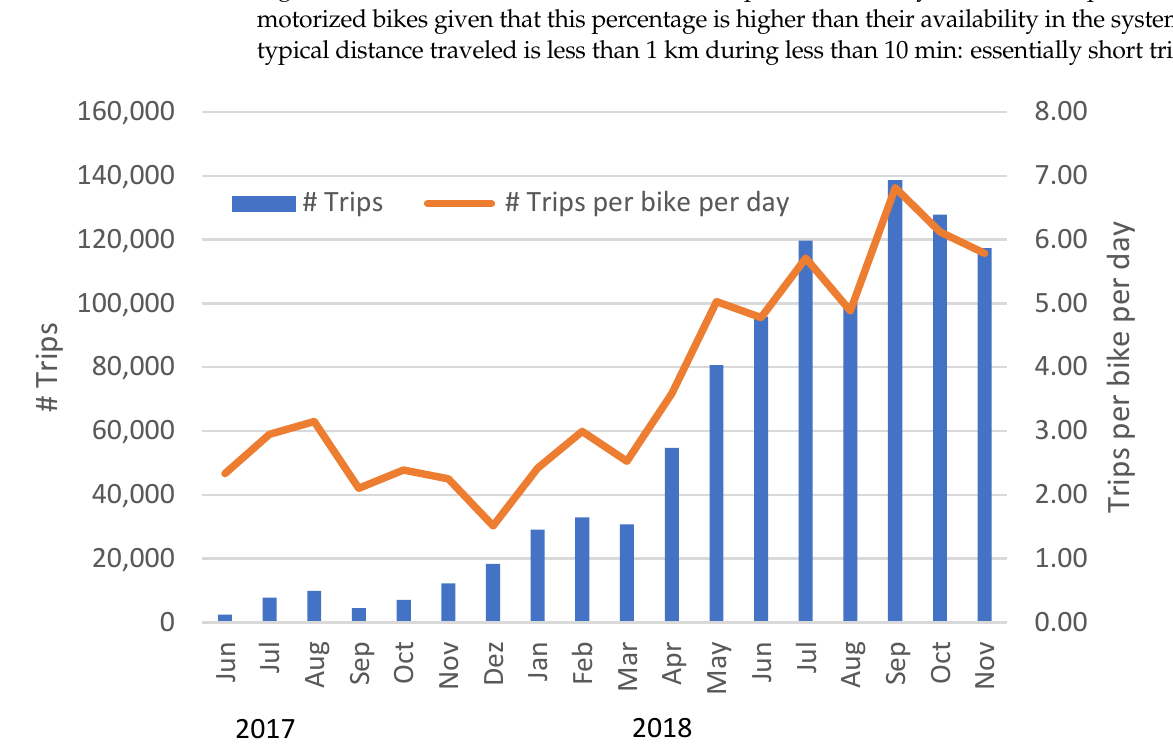
( b ) Figure 8. Trip characteristics ( a ) Number of trips per distance in 2018; ( b ) Number of trips per duration in 2018.